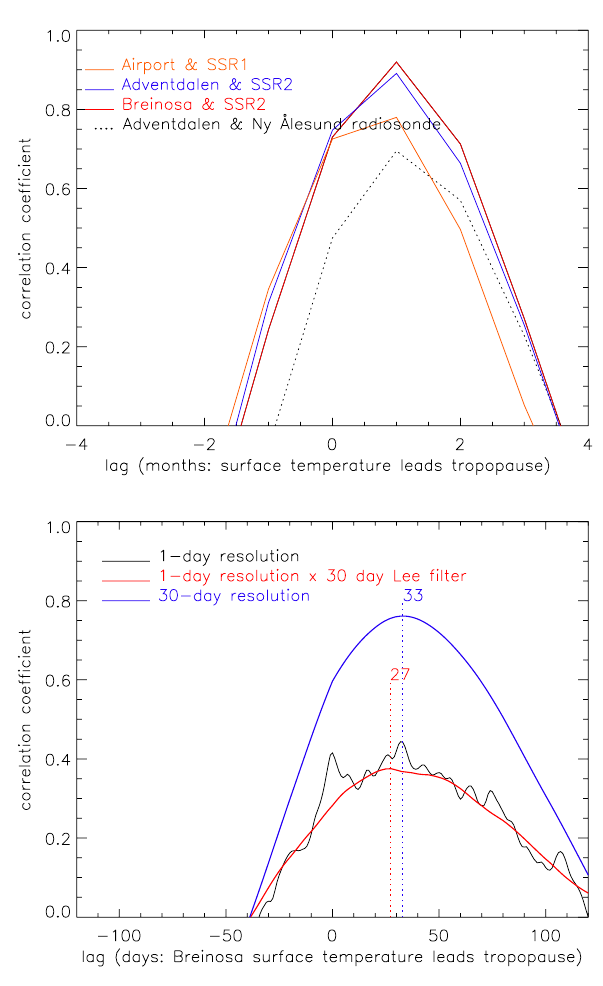
Fig. 4. Upper panel: updated version of results from Hall et al. (2009) showing correlations between tropopause determinations and temperature measurements (see text and Hall et al. (2009) for details. Lower panel: correlations based on daily data (variable line), 30-day smoothed correlation (smooth lower line), and corre- lation between daily temperature and 30-day smoothed tropopause height (upper smooth line). All temperatures from